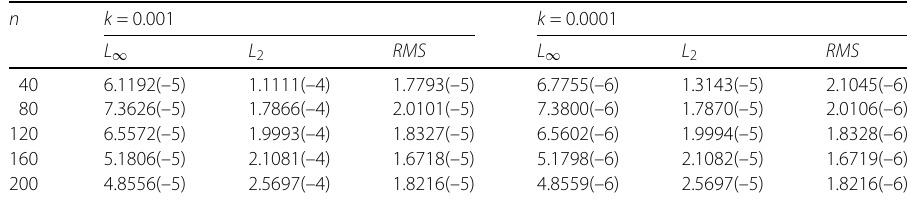
, κ = 0.5, L = 7, n = 200, 12